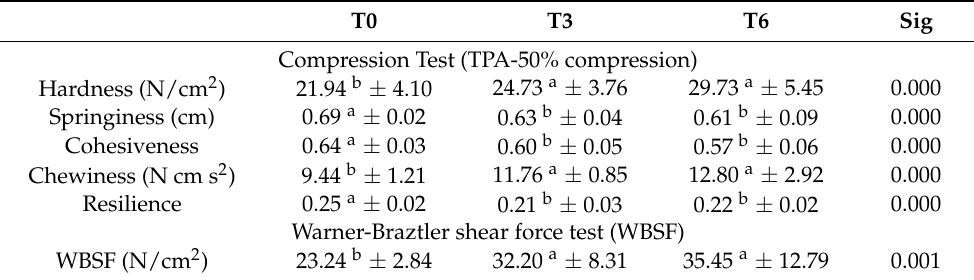
Table 3. Textural properties of Montanera Iberian dry-cured lomito as affected by pre-cure freezing time. T0 T3 T6